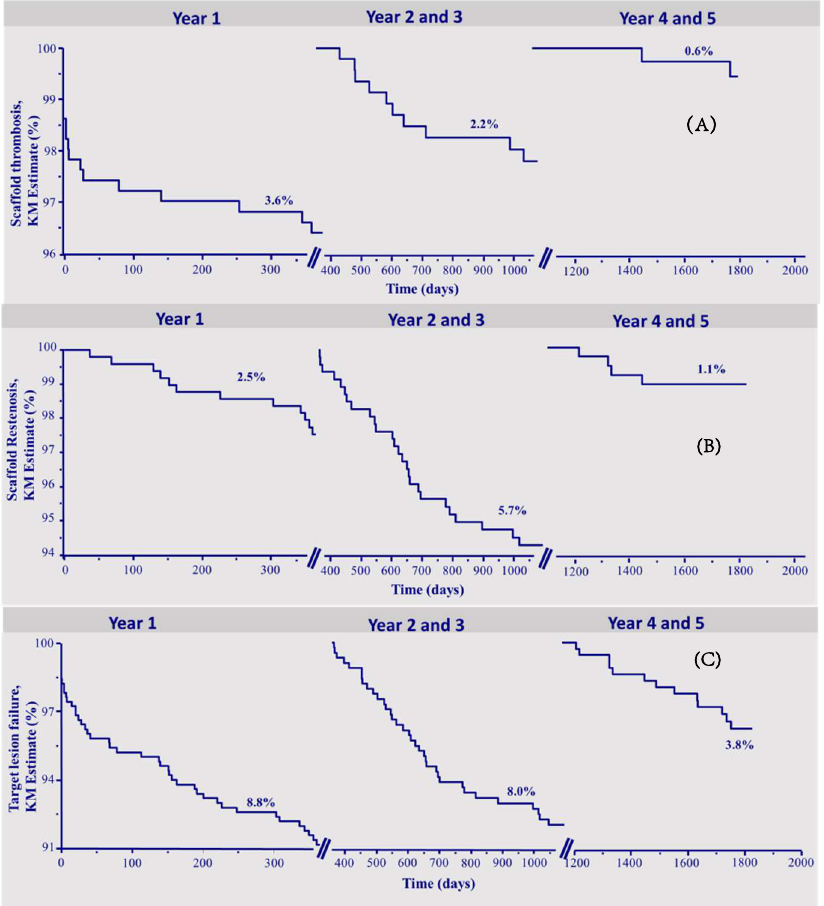
Figure 1. Kapla–Meier survival curves. ( A ) Scaffold thrombosis. ( B ) Scaffold restenosis. ( C ) Target lesion failure.